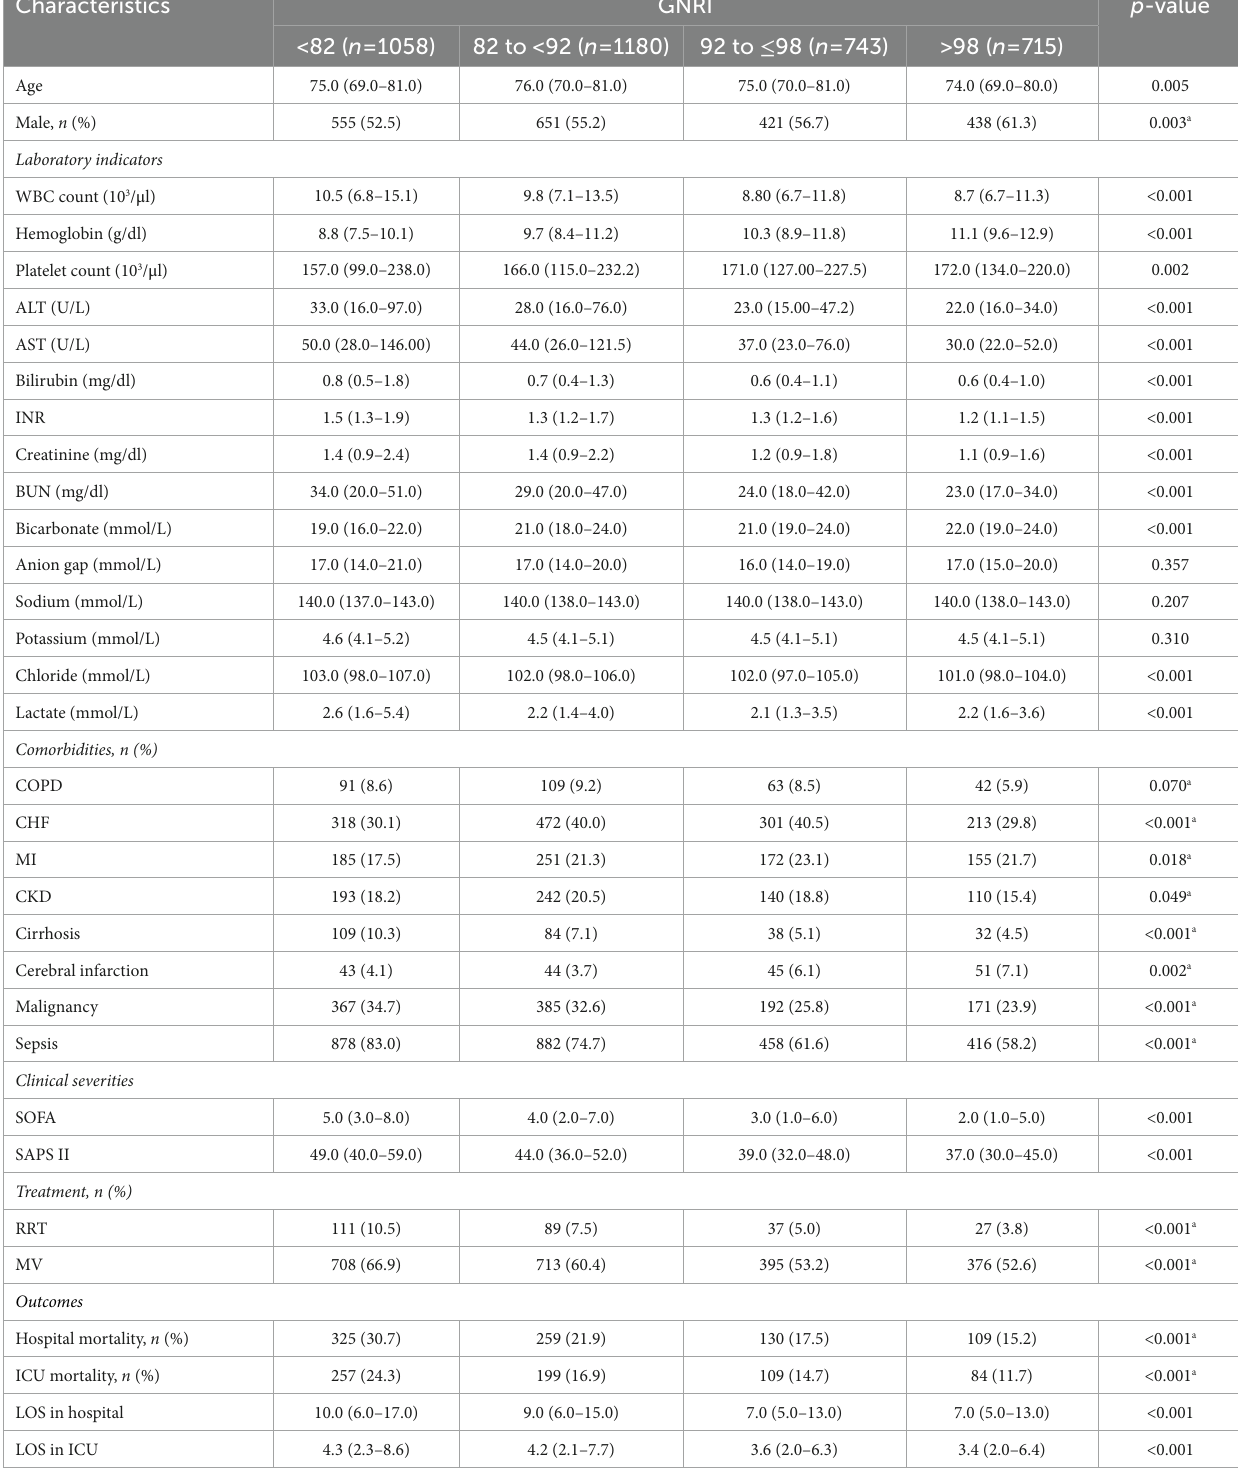
TABLE 1 Baseline characteristics of the study population grouped according to GNRI.